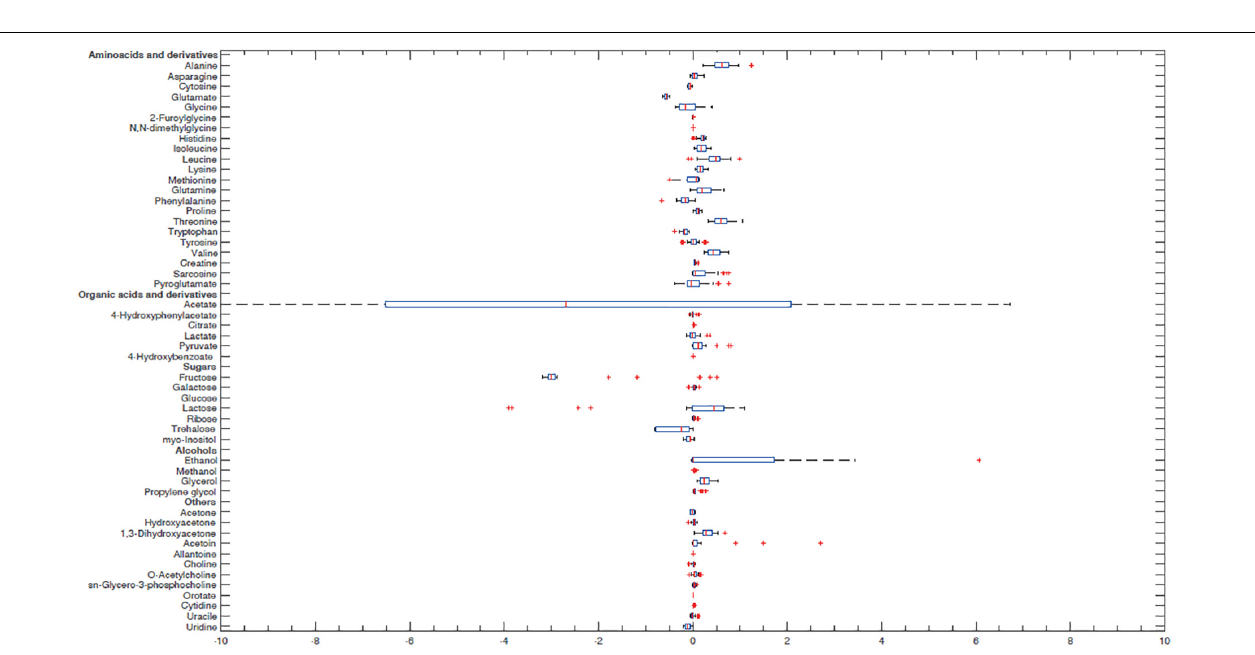
FIGURE 5 | Box plot of Lactobacillus CFS metabolite concentrations. Concentrations were calculated as differences from MRS broth (mmol/L). Lines within the boxes indicate the median values of the samples. Each box represents the interquartile range (25–75th percentile). The extremes of the bars indicate the 10th and 90th percentiles, respectively. Outlier values are indicated (+). Glucose median and acetate interquartile range are not represented because they were out of the range considered.